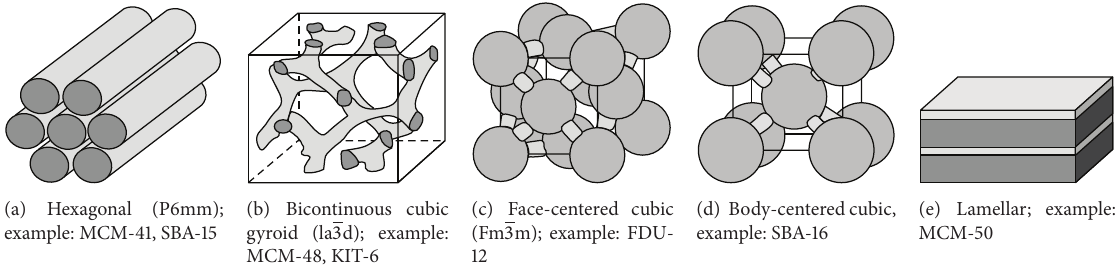
Figure 1: Structures of various ordered mesoporous materials [27].